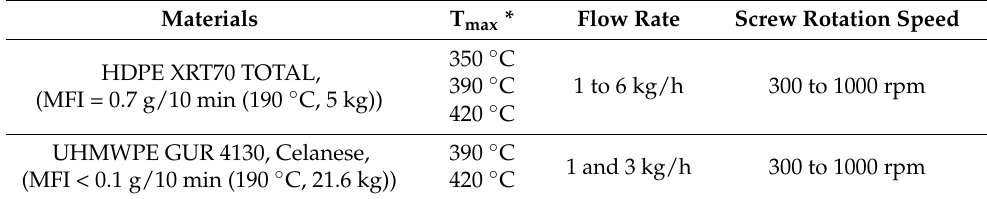
Table 1. Processing conditions used in this study.